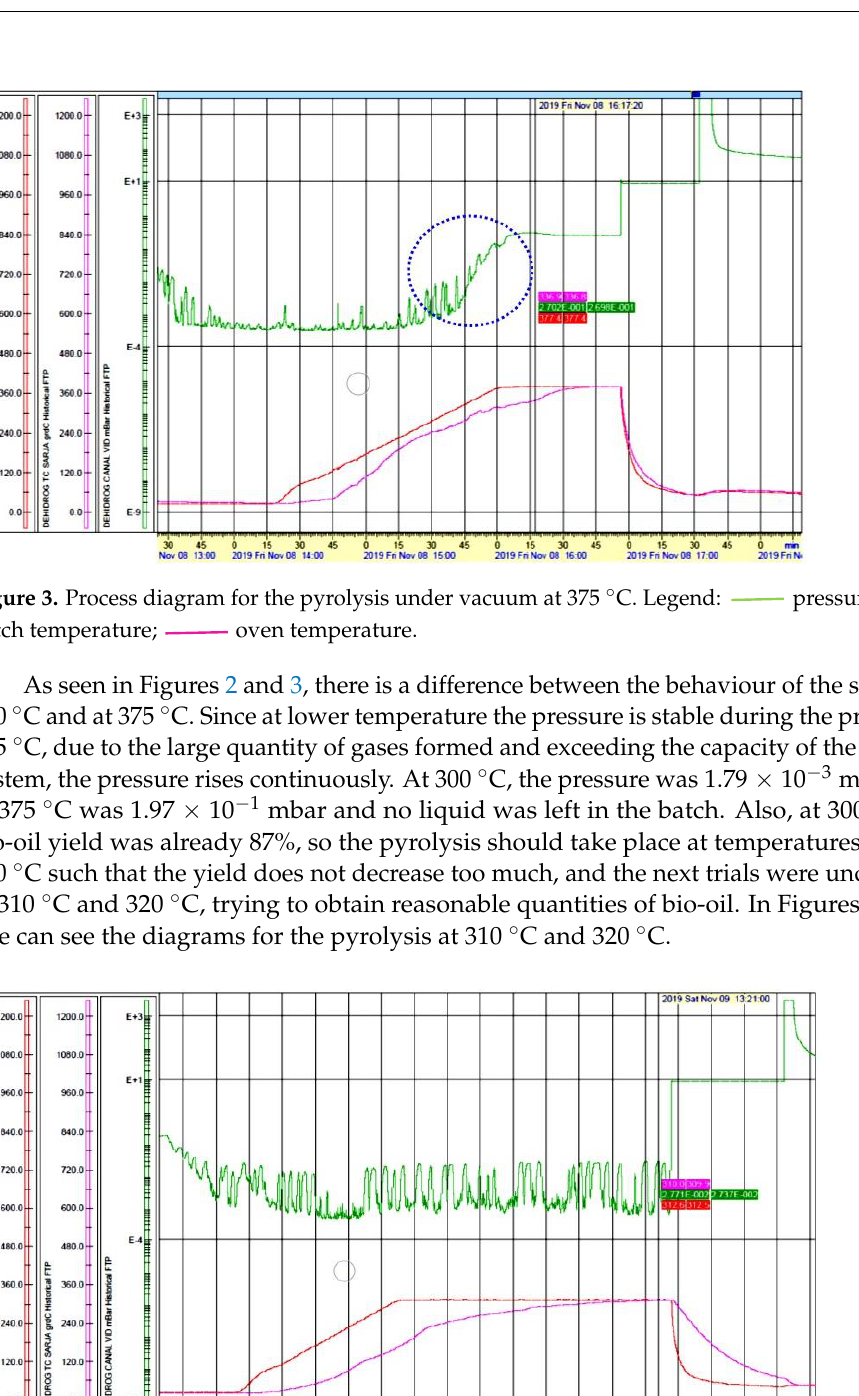
Figure 2. Process diagram for the pyrolysis under vacuum at 300 °C. Legend: pressure; batch temperature; oven temperature.